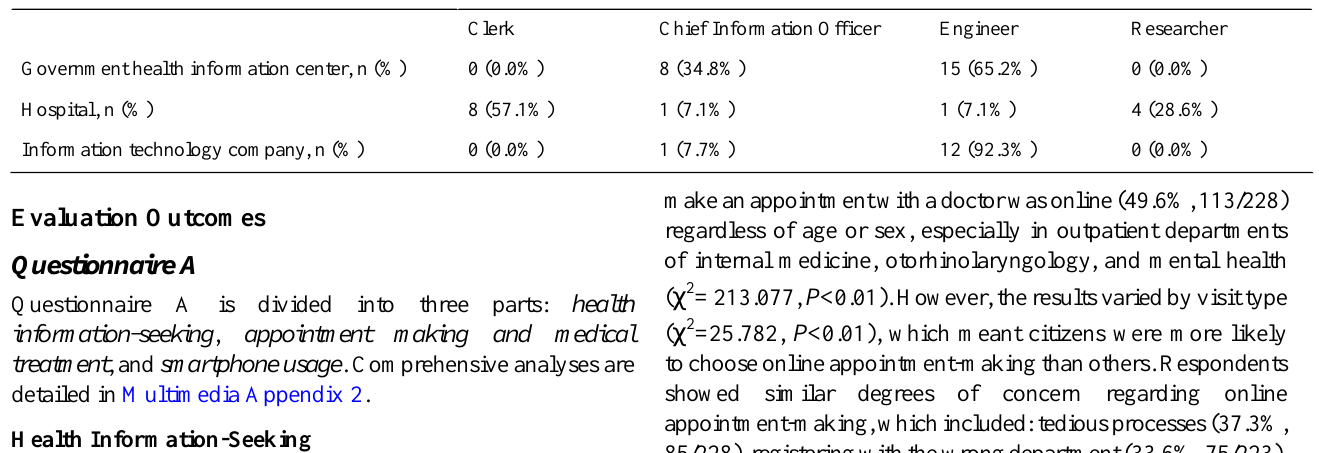
ResearcherEngineerChief Information